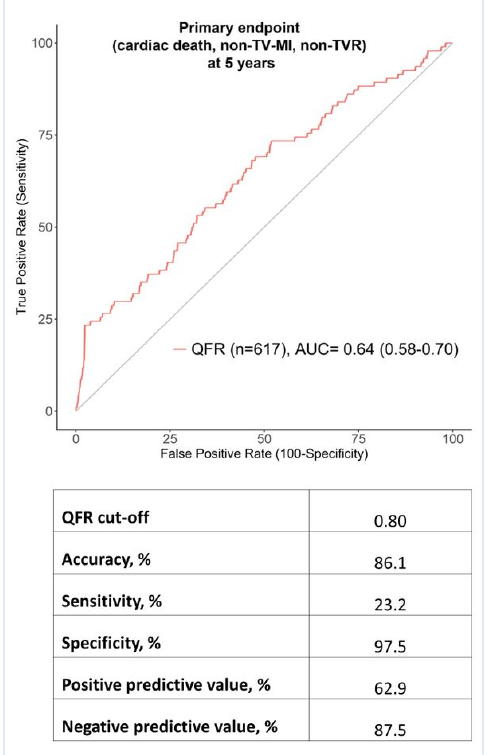
Figure 1. Kaplan-Meier Curves of the Primary Endpoint